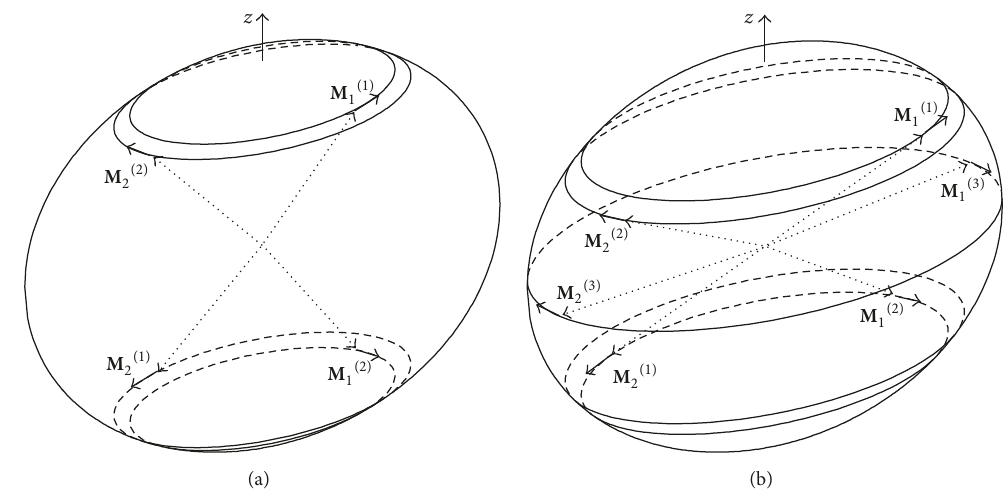
Figure 1: Normal modes of the self-consistent precession of the sublattice magnetization vectors M 1 and M 2 of an ideal antiferromagnetic particle for 𝐸 󸀠 = 𝐸/𝐴 = (a) − 1.003 and (b) − 0.997 with 𝑚 = ±𝑚 max (𝐸) . Hereinafter, all calculations were performed for 𝑘 = 𝐾/𝐴 = 0.01